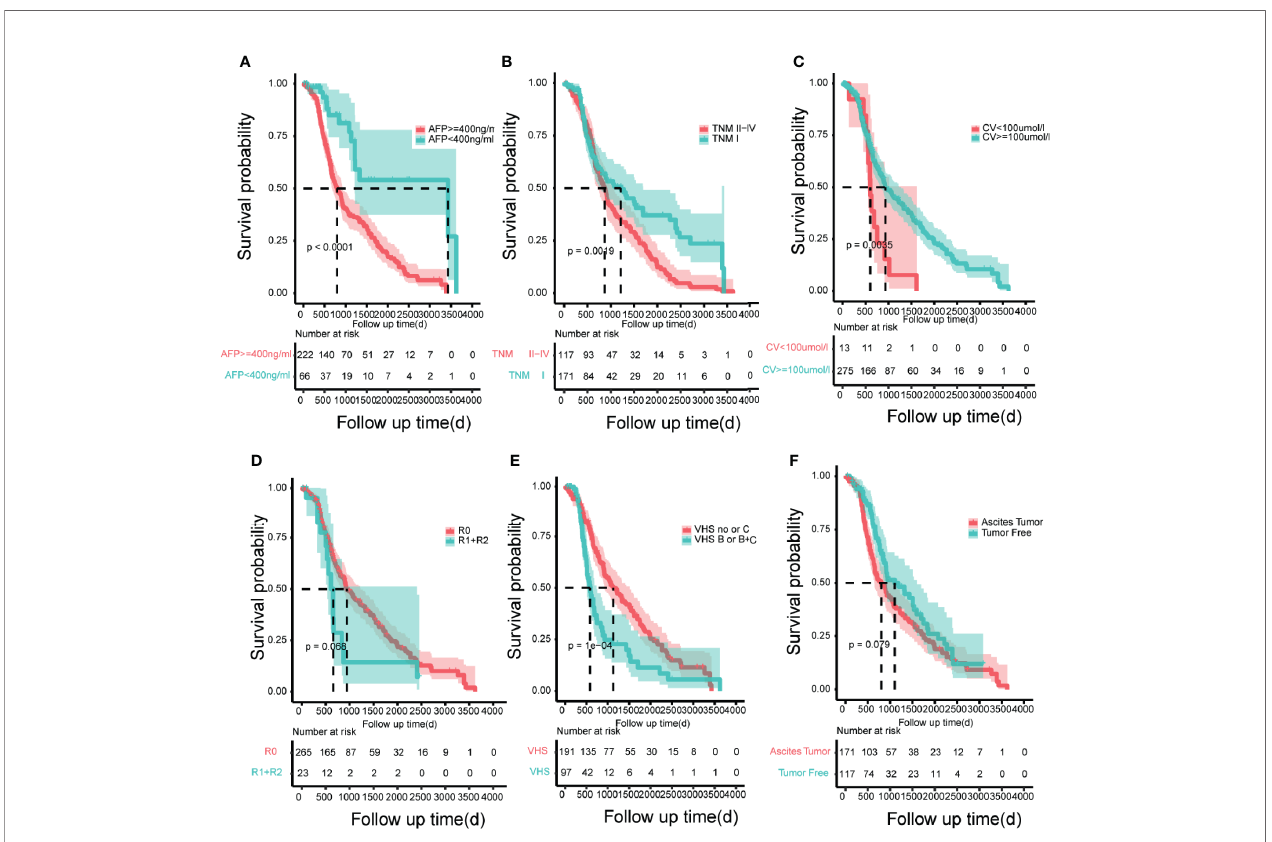
FIGURE 6 | The Kaplan – Meier curves for subgroups of patients. Patients were strati fi ed by the AFP (A) , tumor node metastasis (B) , creatinine value (C) , resection marginal residual tumor (D) , viral hepatitis serology (E) and patient ’ s tumor status (F) in the training